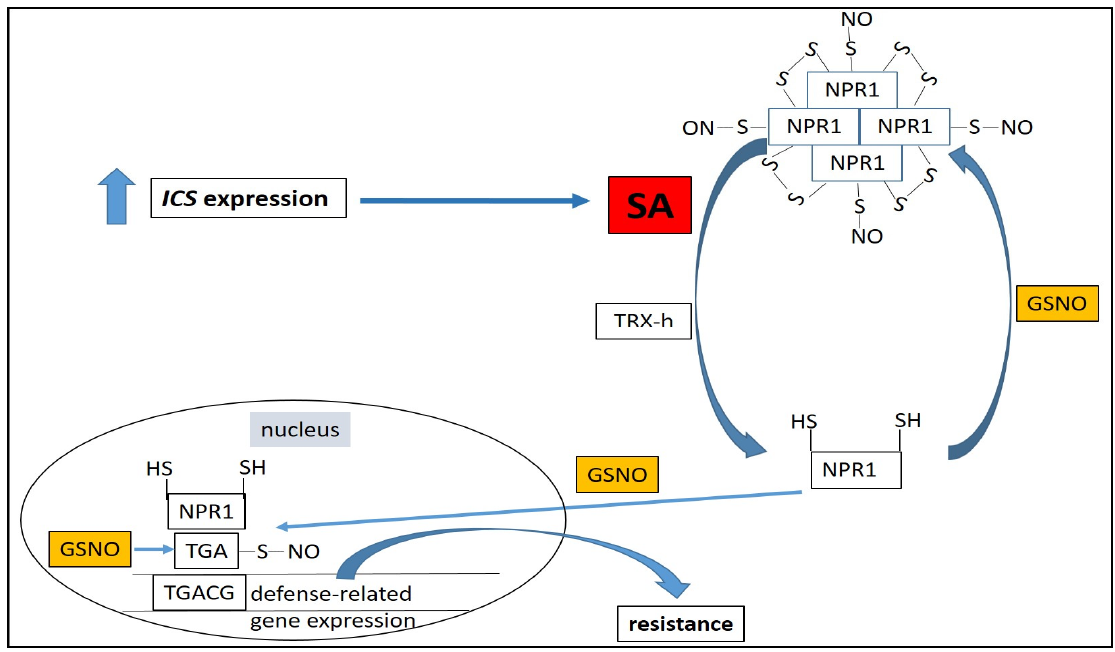
Figure 3. Salicylic acid (SA) accumulation induces defense gene expression through conformational changes of non-expressor of pathogenesis-related 1 protein (NPR1). During pathogen challenge changes in the redox status of plant cells leads to a reduction in cysteine residues in NPR1 and NPR1 monomers are released from the oligomeric, complex catalyzed by thioredoxins (TRX-h). In contrast, of NPR1 monomers by GSNO facilitates oligomerization. SA binding to the NPR1 oligomer is necessary S -nitrosylation of NPR1 monomers by GSNO facilitates oligomerization. SA binding to the NPR1 for the final activation of monomerization. Activated NPR1 monomers are translocated from the oligomer is necessary for the final activation of monomerization. Activated NPR1 monomers are cytoplasm to the nucleus mediated by GSNO. The activated NPR1 monomer induces PR expression translocated from the cytoplasm to the nucleus mediated by GSNO. The activated NPR1 monomer in cooperation with TGA transcription factors and GSNO mediated S -nitrosylation of TGA enhances induces PR expression in cooperation with TGA transcription factors and GSNO mediated S - defense gene nitrosylation of TGA enhances defense gene expression.